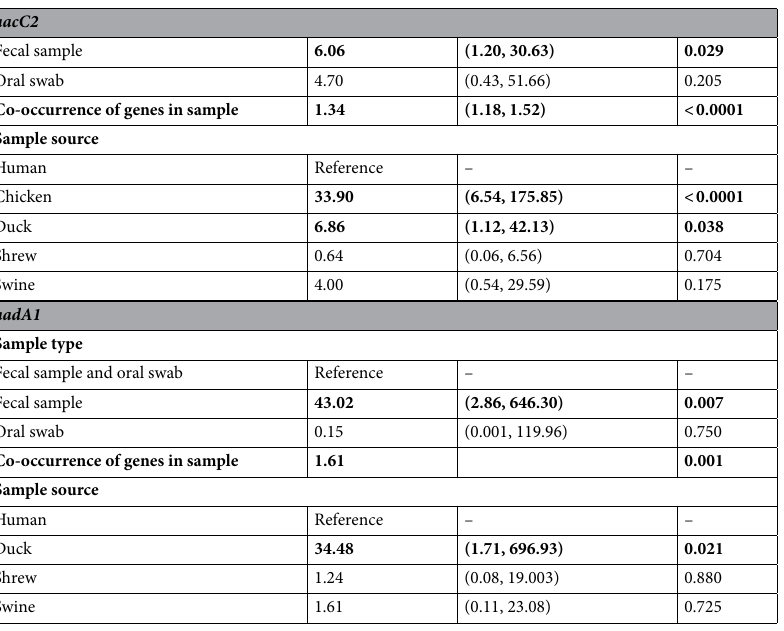
Table 2. Logistic regression analysis of predictors associated with the detection of antibiotic resistance genes of public health importance in an urban informal settlement in Kathmandu, Nepal, 2017. Bolded rows show outcomes with p < 0.05. *Mixed effects models; only fixed effect output is shown. **Fecal samples comprise rectal swabs (swine, rodents, shrews), cloacal swabs (ducks, chickens), and feces (humans). ***As measured by total number of genes (out of n = 88) positive in the